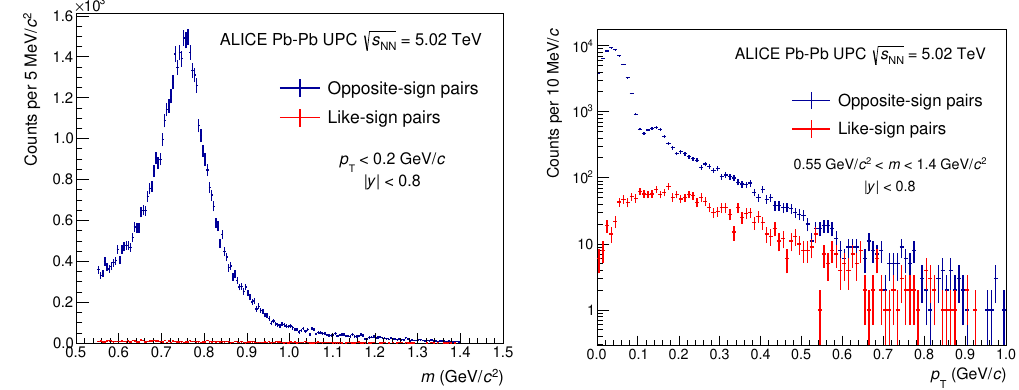
Figure 2 . (Colour online). Invariant mass (left) and transverse momentum (right) distributions for opposite-sign (blue) and like-sign (red)